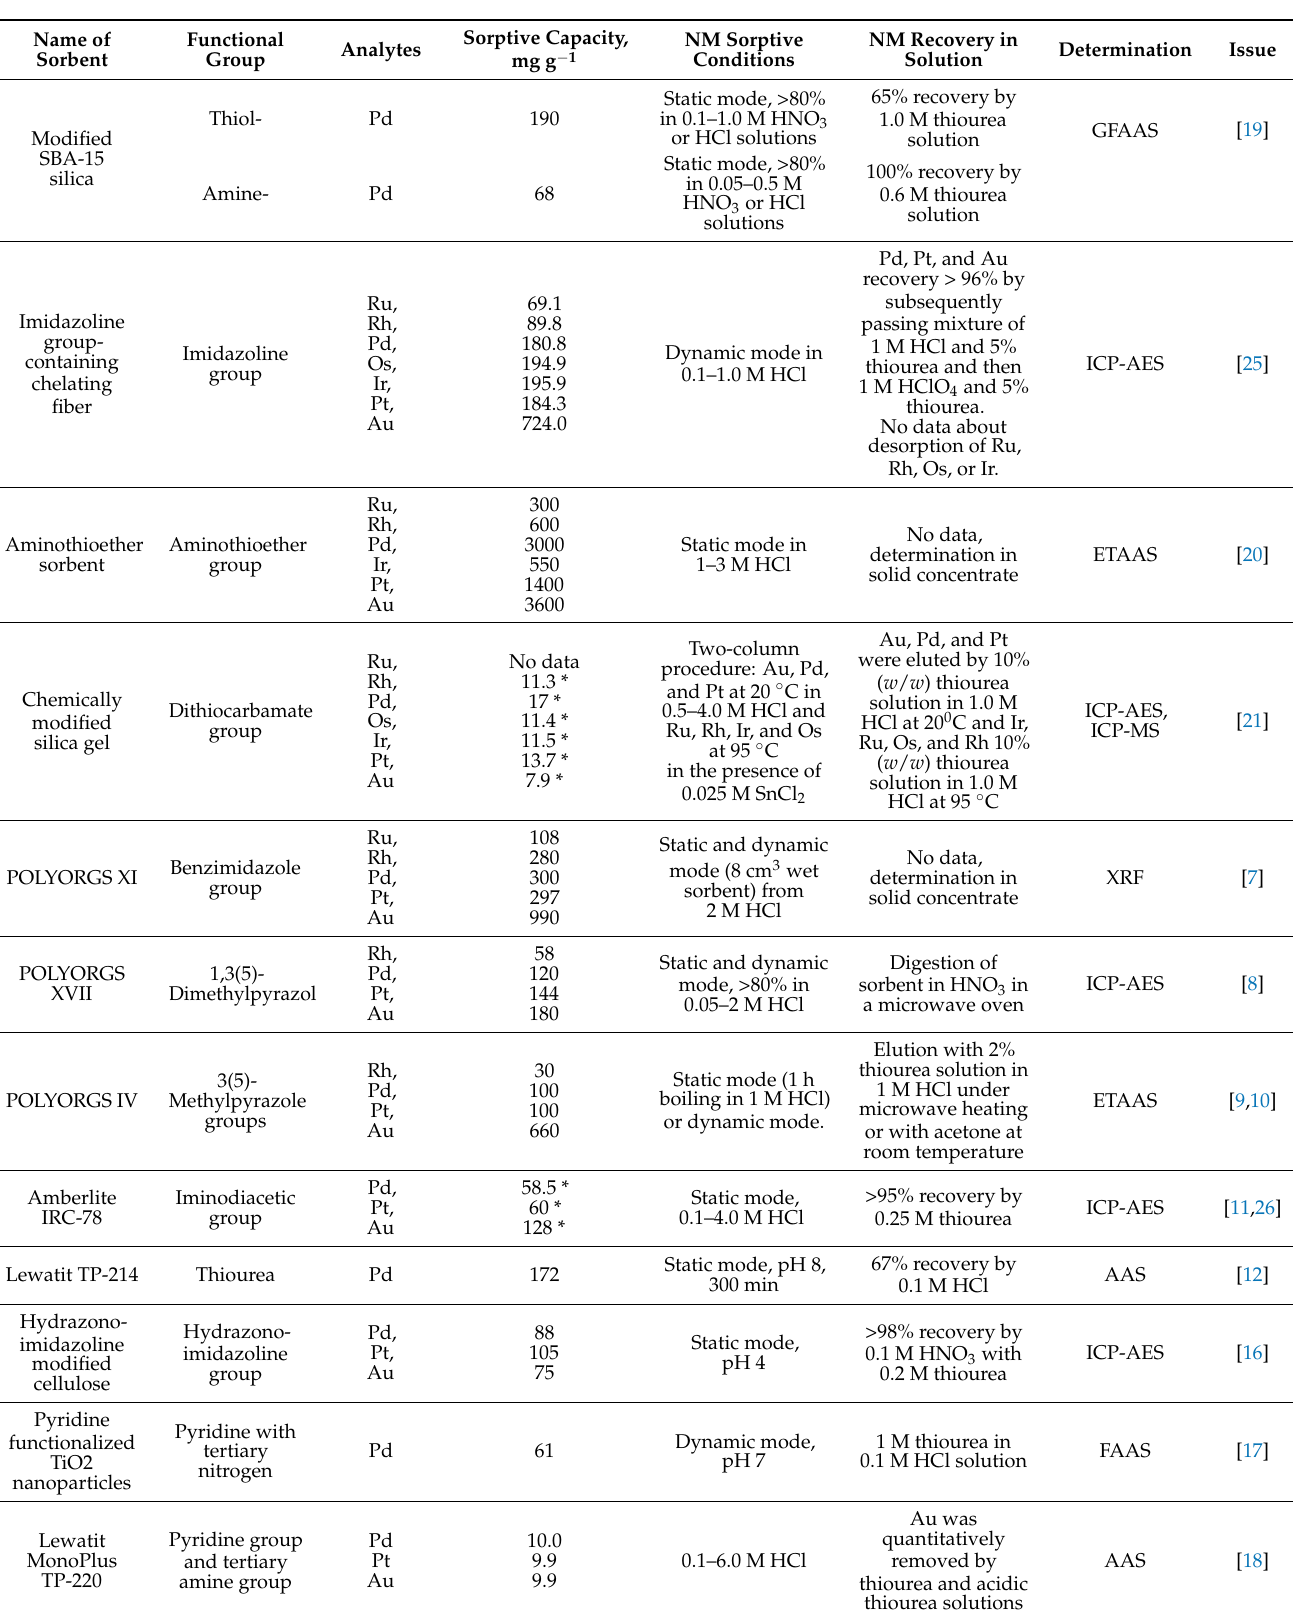
Table 1. Examples of S- and/or N-containing complex-forming resins for NM